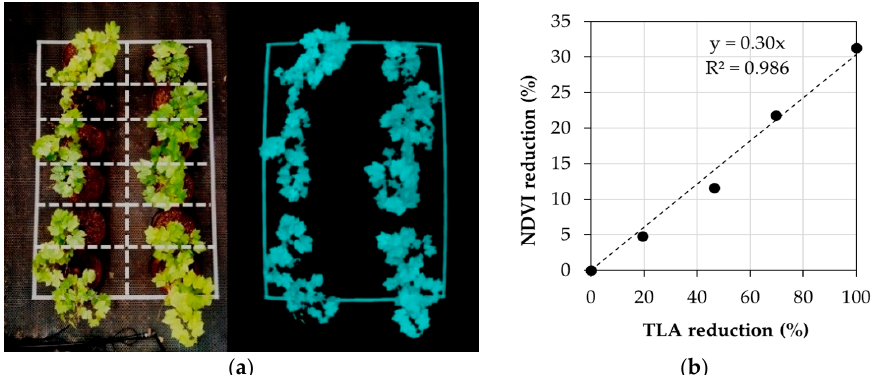
Figure 4. ( a ) Example of the mask used to isolate the vines; ( b ) The relationship between them. Normalized Difference Vegetation Index (NDVI) reduction (%) and Total Leaf Area (TLA) reduction (%) as pixel-based.